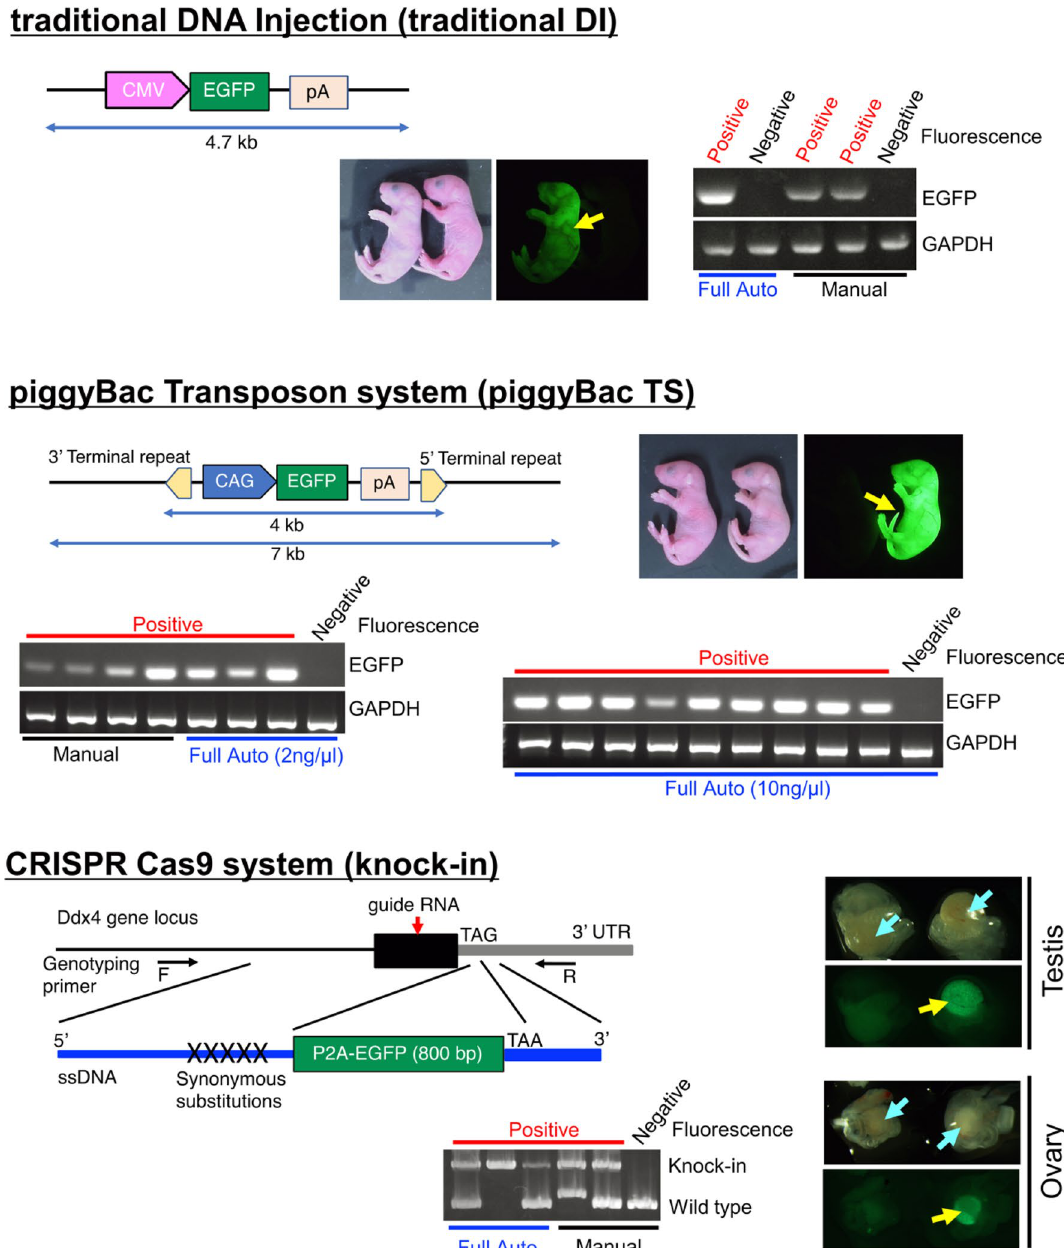
Figure 6. EGFP expression and gene transfer in genetically modified mice produced by 3 different methods. Different DNA constructs were used to produce the 3 types of genetically modified mice. Mice produced by fully automated or manual injection were examined for EGFP expression by UV irradiation and for gene modification by genomic DNA PCR. Yellow arrows indicate typical examples of testes and ovaries containing germ cells with confirmed EGFP fluorescence. Blue arrows indicate typical examples of ovaries or testes before UV irradiation. EGFP fluorescence-positive mice were always positive on PCR